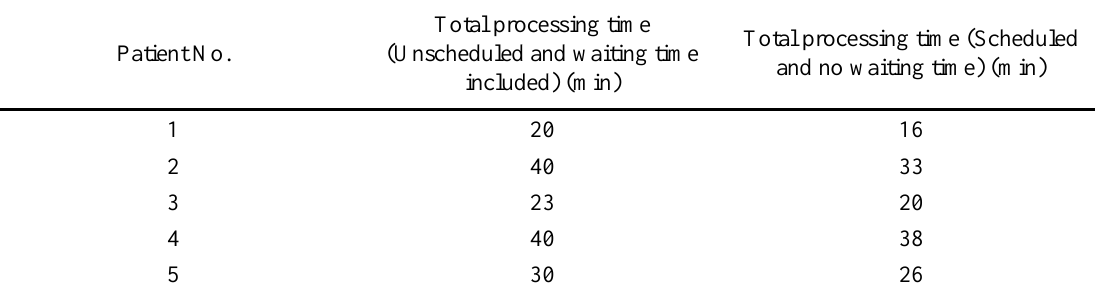
Table 3. Comparison between survey and experimental result.